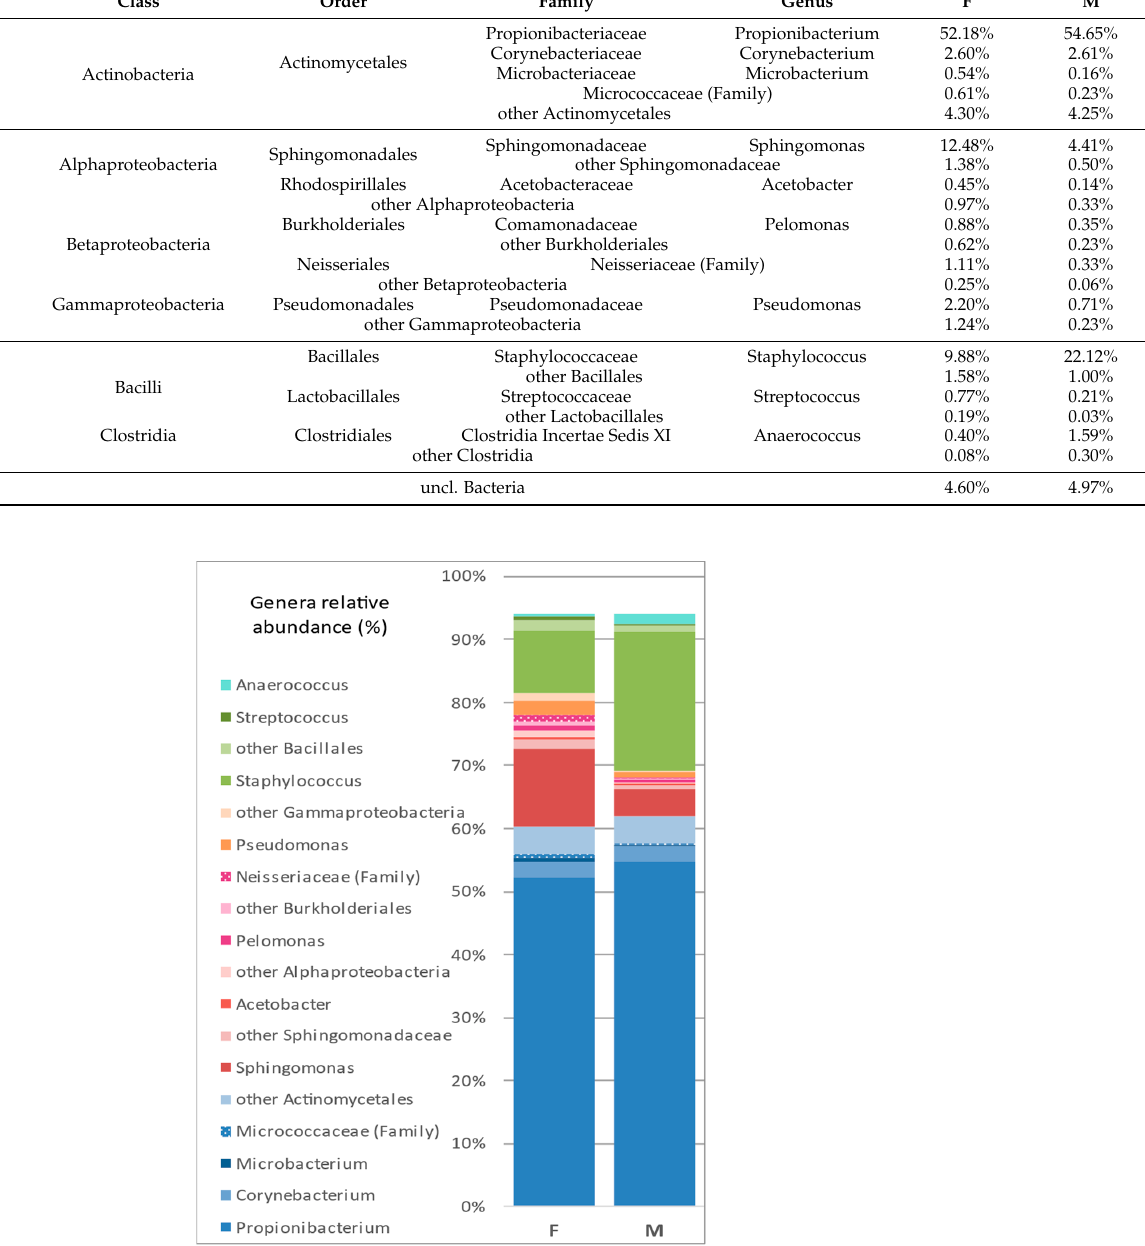
Figure 5. Bar graph of the most abundant genera and their most representative parent taxa. Table 4. Relative abundance of the most abundant genera and of their most representative parent taxa. The LefSe analysis was performed at the phylum level to identify the statistically different taxa between our groups (|LDA score| > 2.0, p -value < 0.05; Table 3 and Figure